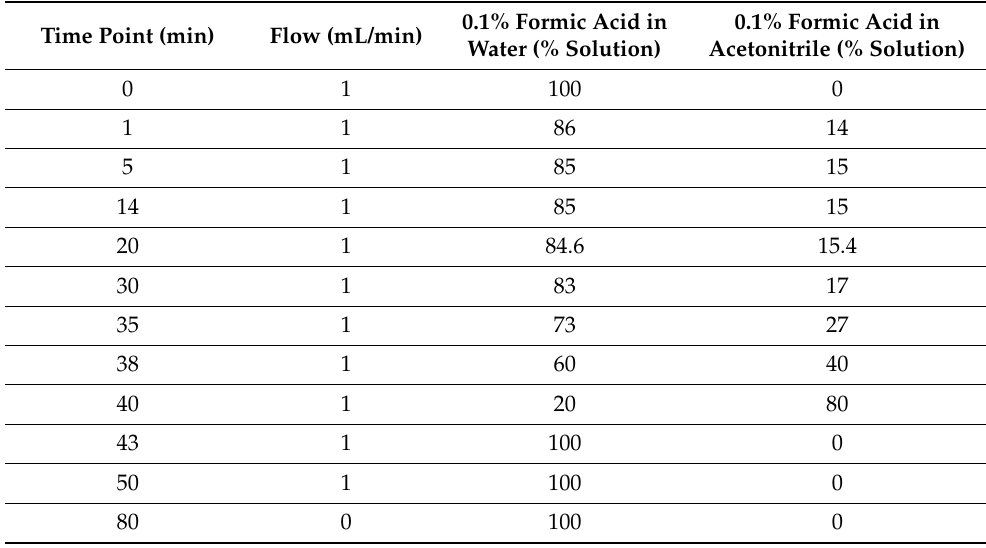
Table 7. Solvent system and elution gradient for HPLC analysis of phenolic acids in blueberry. Time point indicates time since sample begins